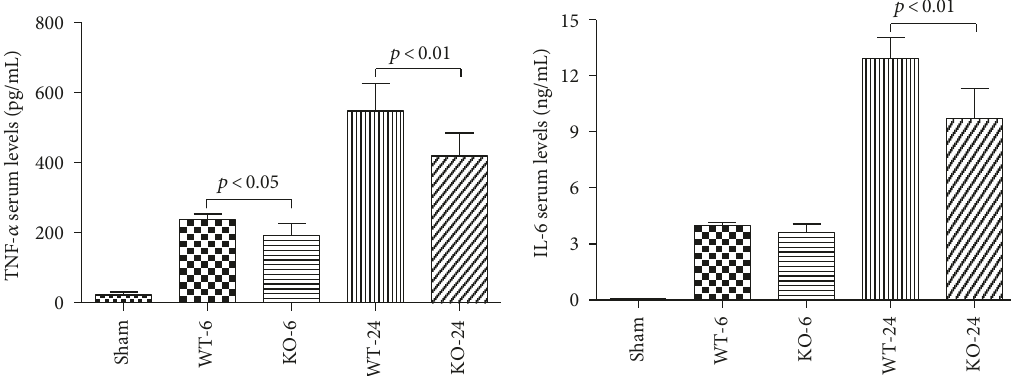
Figure 9: Lack of 5-HT decreases the level of serum cytokines in CLP-induced sepsis. The levels of serum TNF- α and IL-6 were measured with commercial ELISA kits according to the instructions of the manufacturer. A lack of 5-HT reduced the serum TNF- α and IL-6 concentrations ( n = 6 , mean ± SD, TNF- α : p < 0 05 versus the WT-CLP group at 6h after the CLP administration. p < 0 01 versus the WT-CLP group at 24 h after the CLP administration; IL-6: p < 0 01 versus the WT-CLP group at 24 h after the CLP